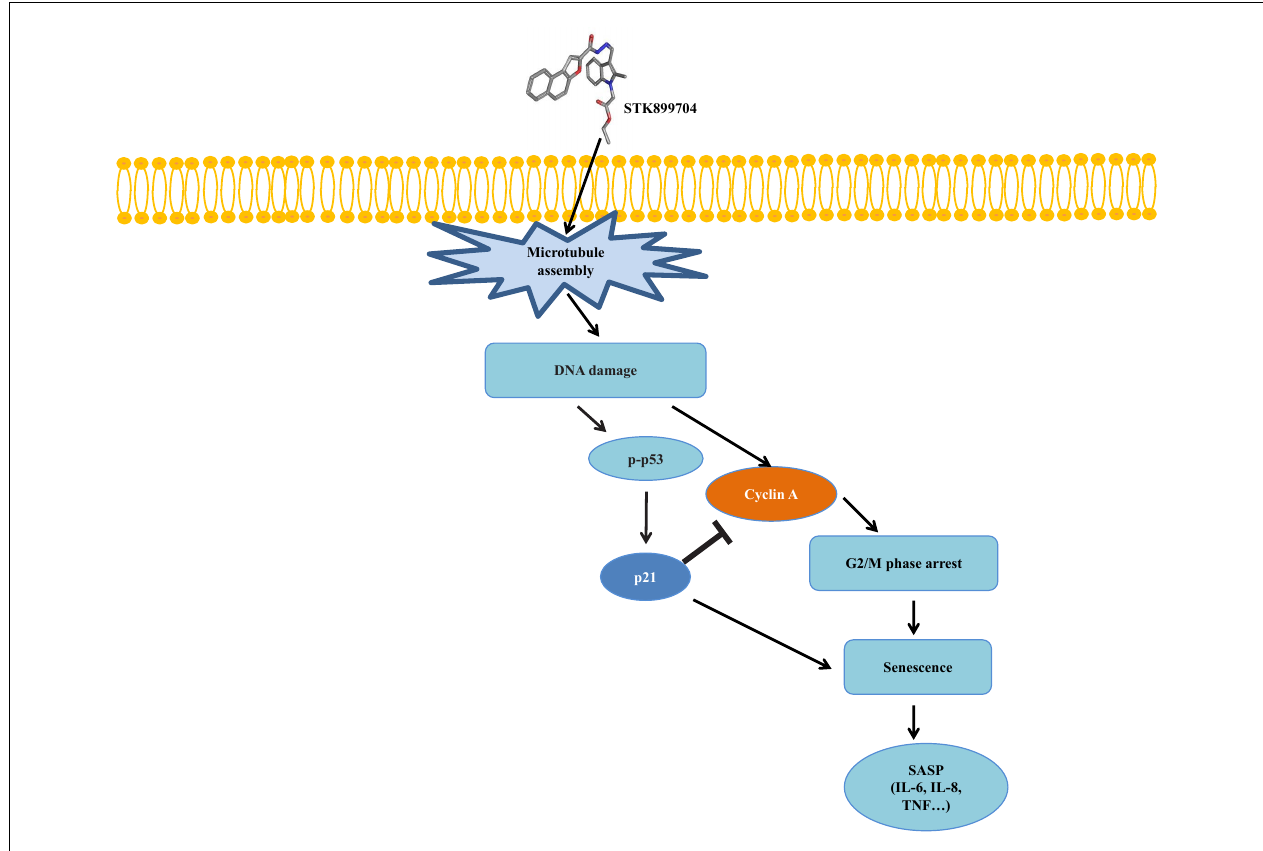
FIGURE 8 | Mimetic diagram of STK899704 efficacy pathway in A549 cells. STK899704 induces cell cycle arrest and senescence through a p53-associated pathway. STK899704 can induce tubulin aggregation, suffering DNA damage and p53 is activated. Mitosis arrest is induced by p53 and followed by cellular